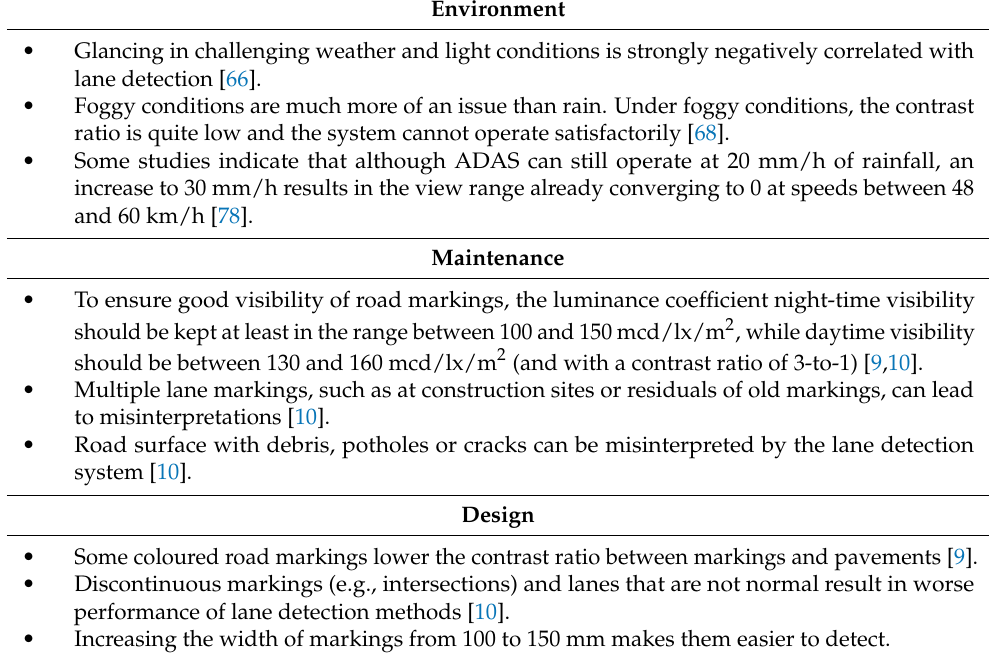
Table 7. Limiting factors in lane